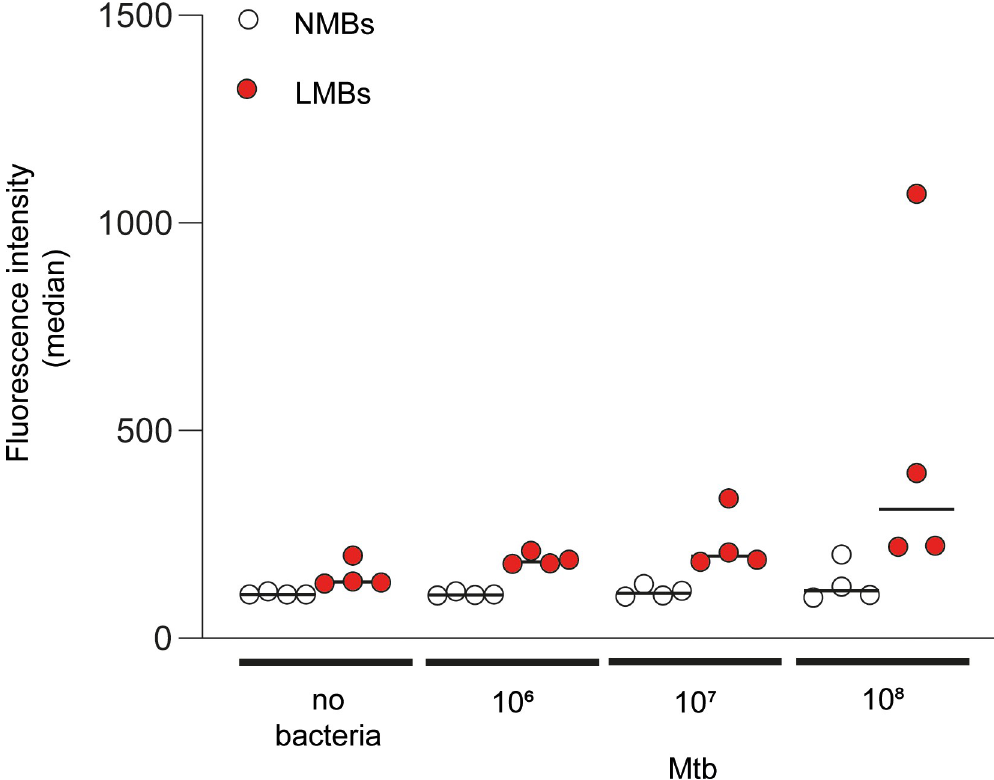
Fig 1. Mtb binds to Lipobiotin-functionalized magnetic beads (LMBs). mCherry-expressing Mtb bacteria were incubated in the presence of non-functionalized magnetic beads (NMBs) or lipobiotin-functionalized magnetic beads (LMBs) for 1h